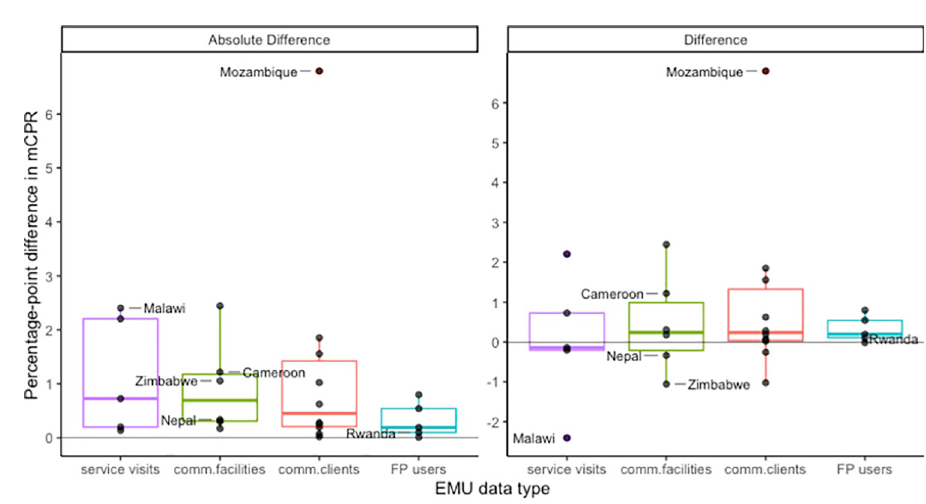
Fig 5. Differences in mCPR estimates including EMU vs excluding EMU. The plot shows boxplots of the absolute and raw differences between mCPR estimates obtained from a model that included an EMU modelling component and estimates obtained from a survey-only